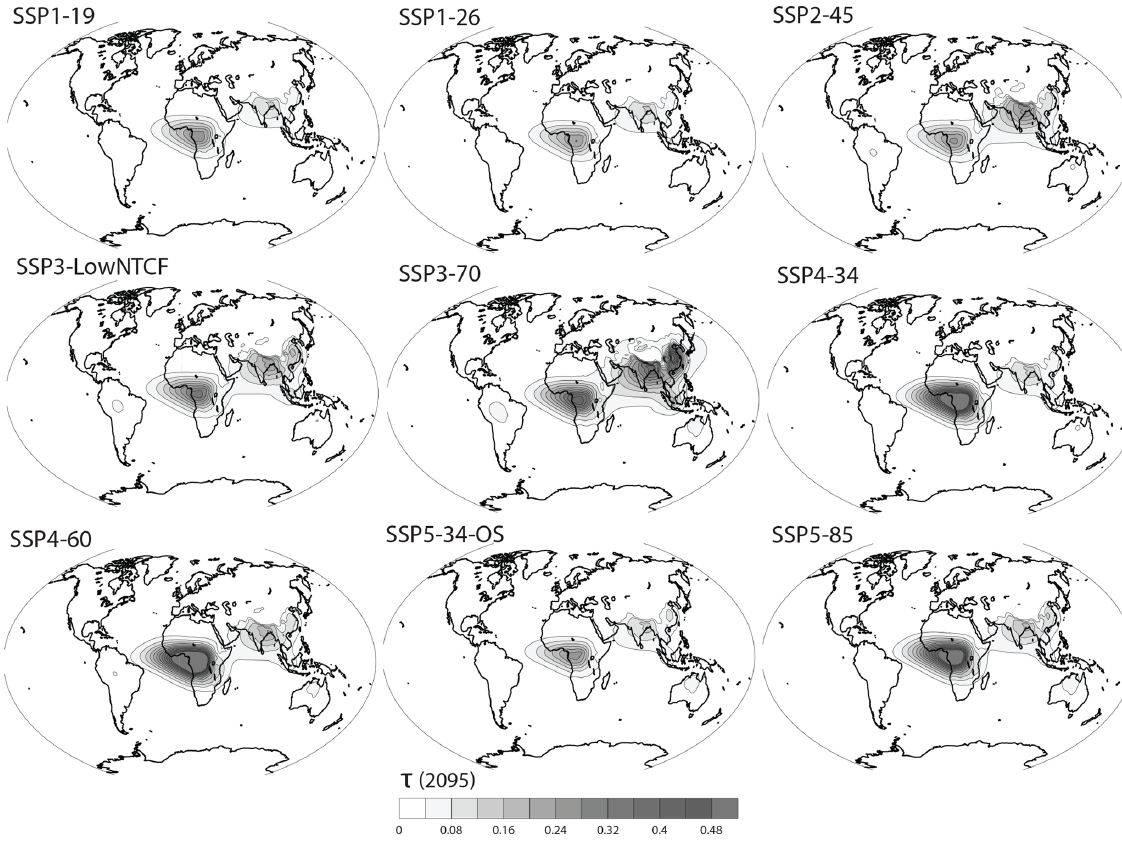
Figure A3. τ scenarios for the mid-2090s in MACv2-SP. As in Fig. A2, but projection for the